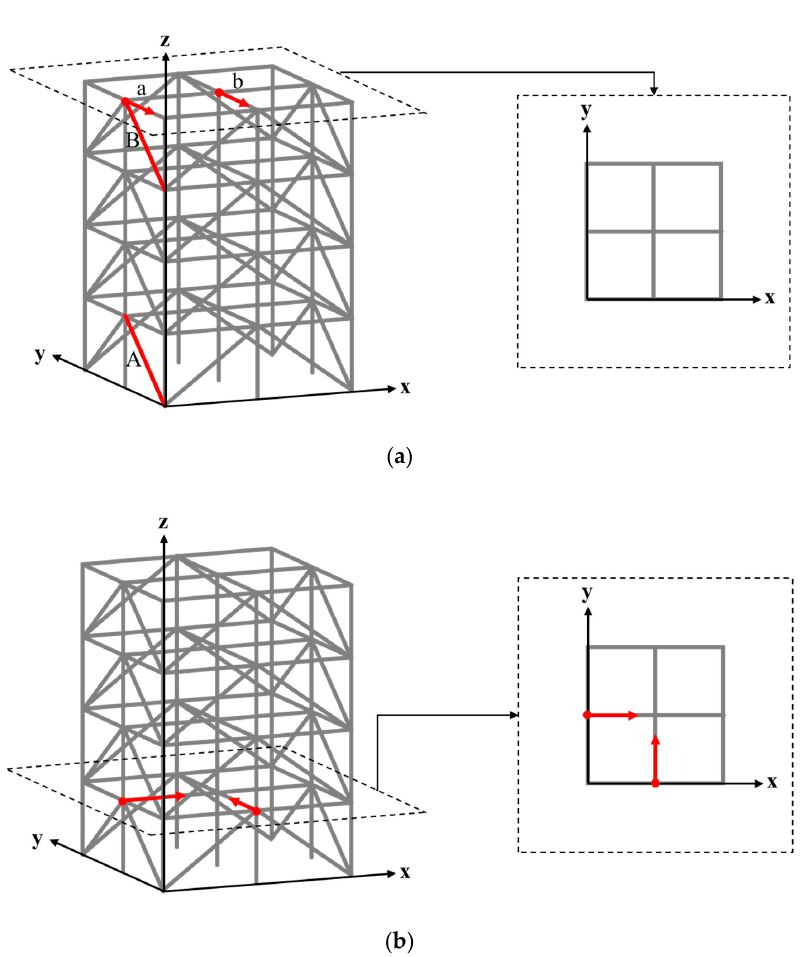
Figure 4. Finite element model of the ASCE structural health monitoring benchmark structure with marked positions of ( a ) the damaged braces and response measurement and ( b ) the excitations.